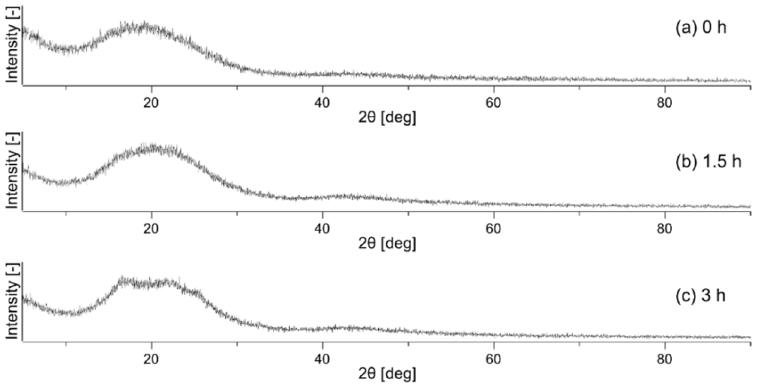
Figure 4. X-ray diffraction profile of unheated sample ( a ), sample after heat treatment for 1.5 h ( b ), and sample after heat treatment for 3 h ( c ).